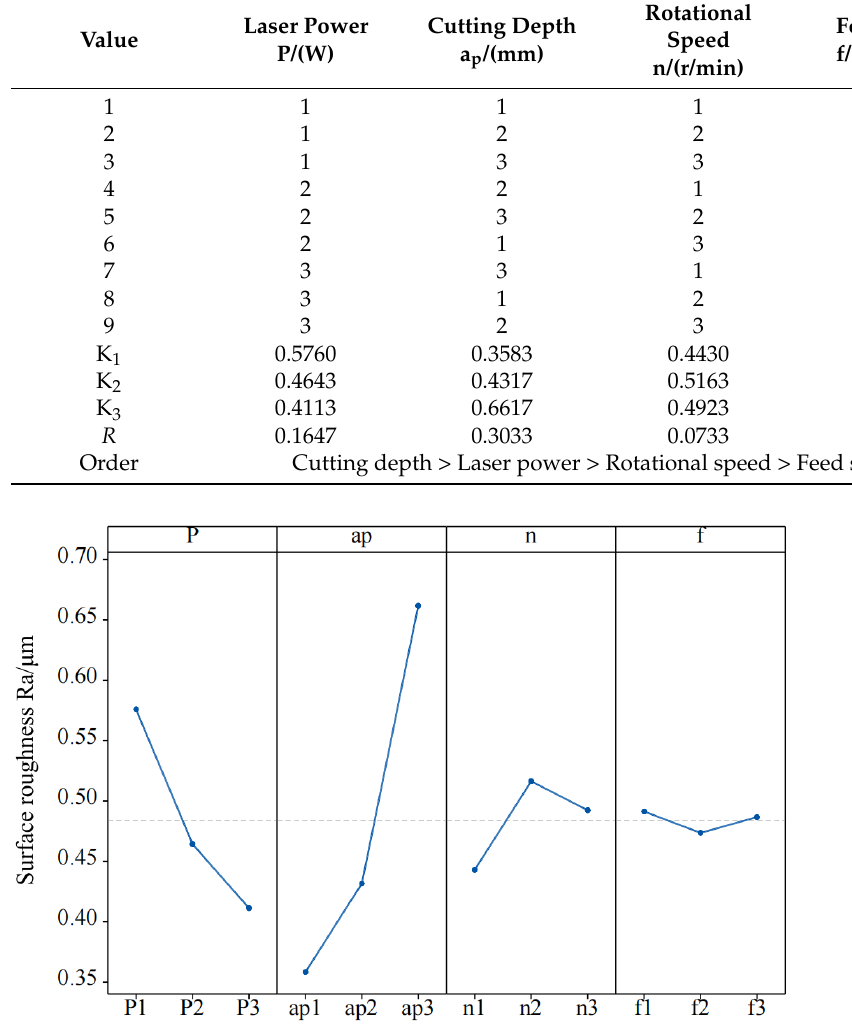
Figure 3. Main effect change of mean surface roughness.